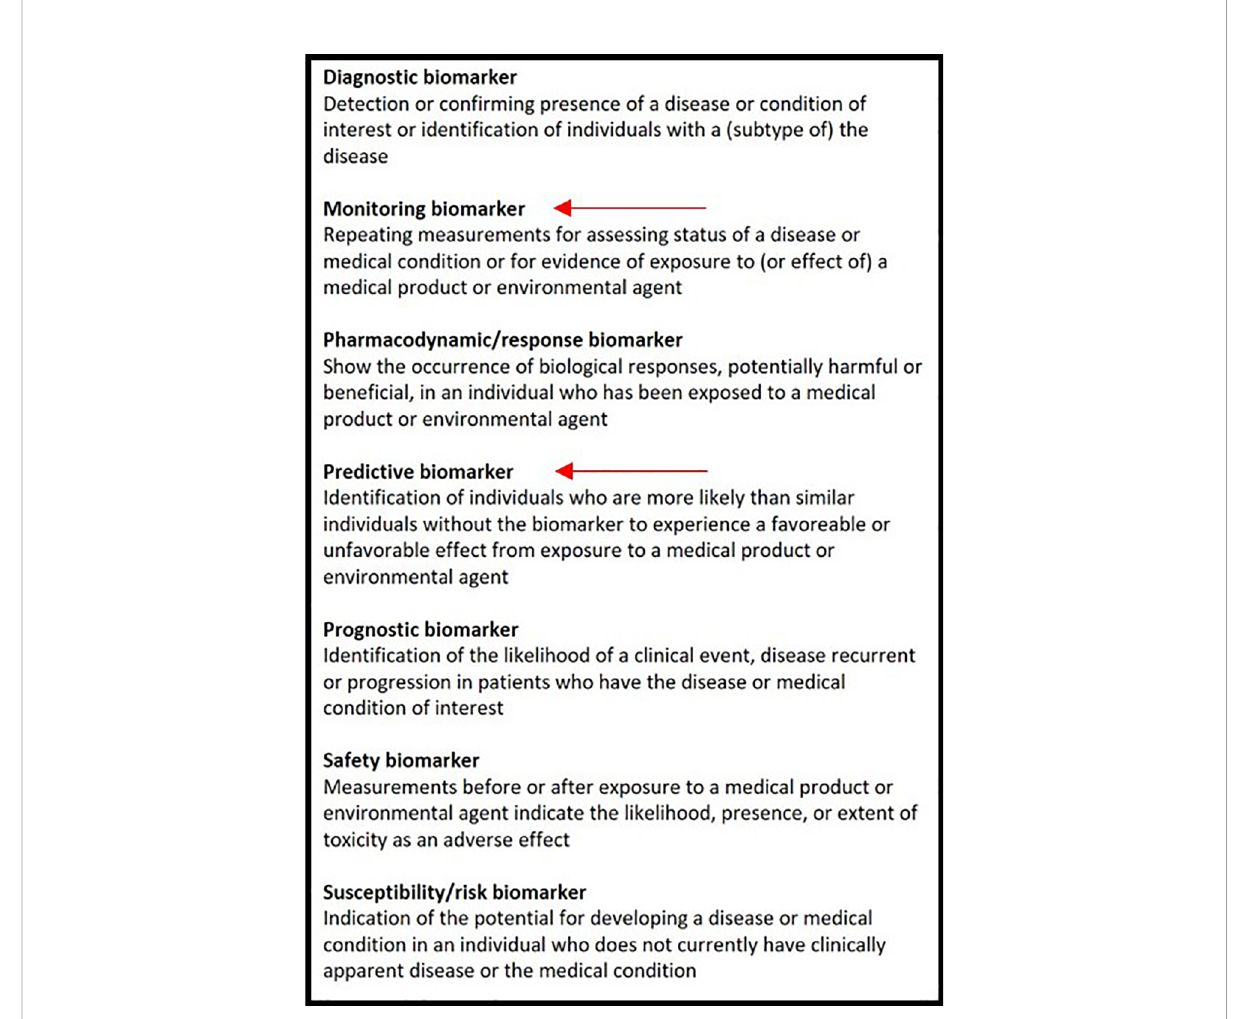
FIGURE 1 The biomarker classi fi cation according to the BEST biomarker categories. The red arrows indicate in which category EGFR-directed PET tracers could be